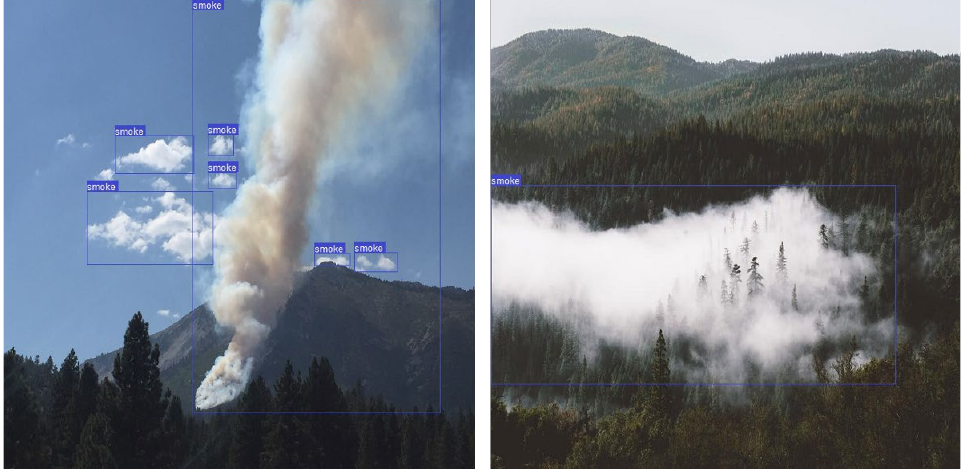
Figure 12. Limitations of the proposed wildfire smoke detection system.